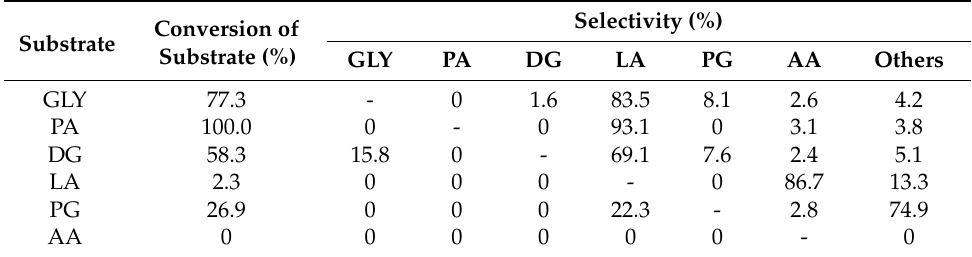
Table 3. The composition of the reaction mixture after the conversion of various substrates in the presence of Cu NPs and NaOH. Selectivity (%) Conversion of Substrate Substrate (%) GLY PA DG LA PG AA Others GLY 77.3 PA 100.0 DG 58.3